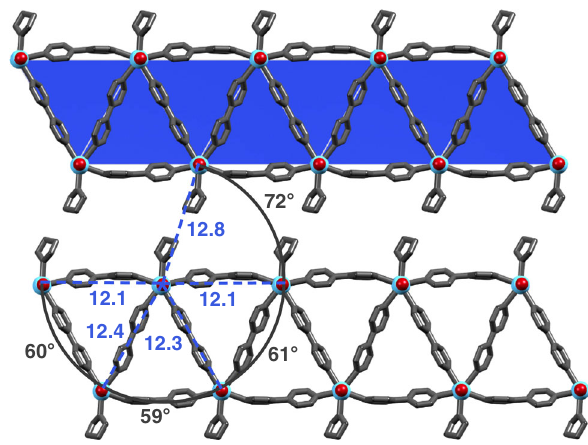
Fig. 4 Structure of 2. Fragment of the structure of 2 as determined by single-crystal X-ray diffraction with indicated Yb···Yb separation lengths (Å) and ∠ Yb···Yb···Yb angles. Selected additional bond lengths (Å, e.s.d.) and angles (°, e.s.d): Yb – I 3.1311(8), 3.1038(8); Yb – N 2.585(5) – 2.666(5); Yb – O 2.454(5); ∠ N – Yb – N 69.0(2) – 71.9(2); ∠ N – Yb – O 73.7(2) – 74.1(2). (Yb, light blue; I, dark